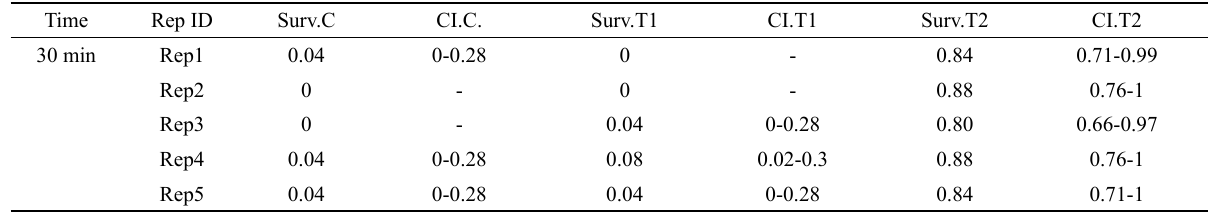
Table 3. – Survival rates and confidence intervals at 95% for the five replicates (Rep ID) of the control (Surv.C and CI.C), treatment 1 (Surv. T1 and CI.T1) and treatment 2 (Surv.T2 and CI.T2) at the end of the experiment (30 min). Time Rep